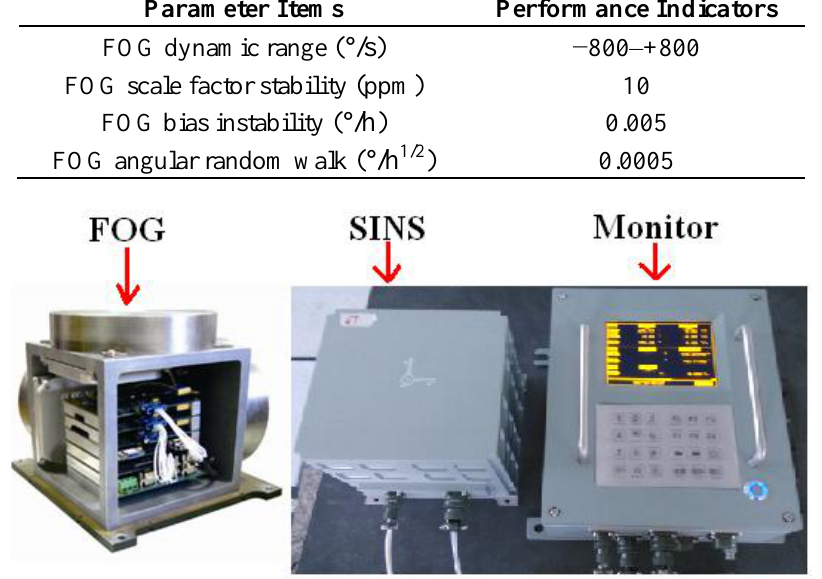
Figure 5. The FOG and FOG-based